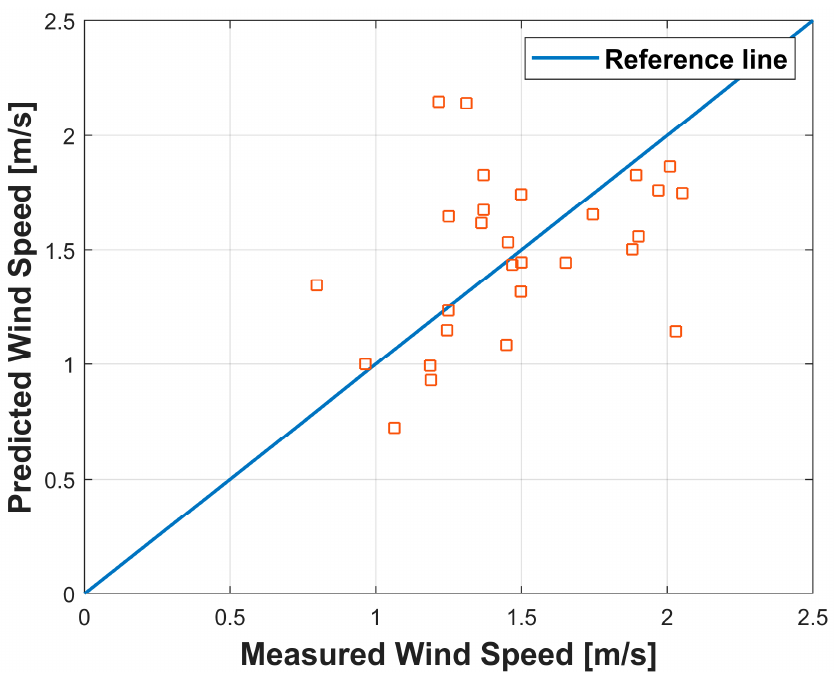
Figure 5. Wind direction variation in K folds.